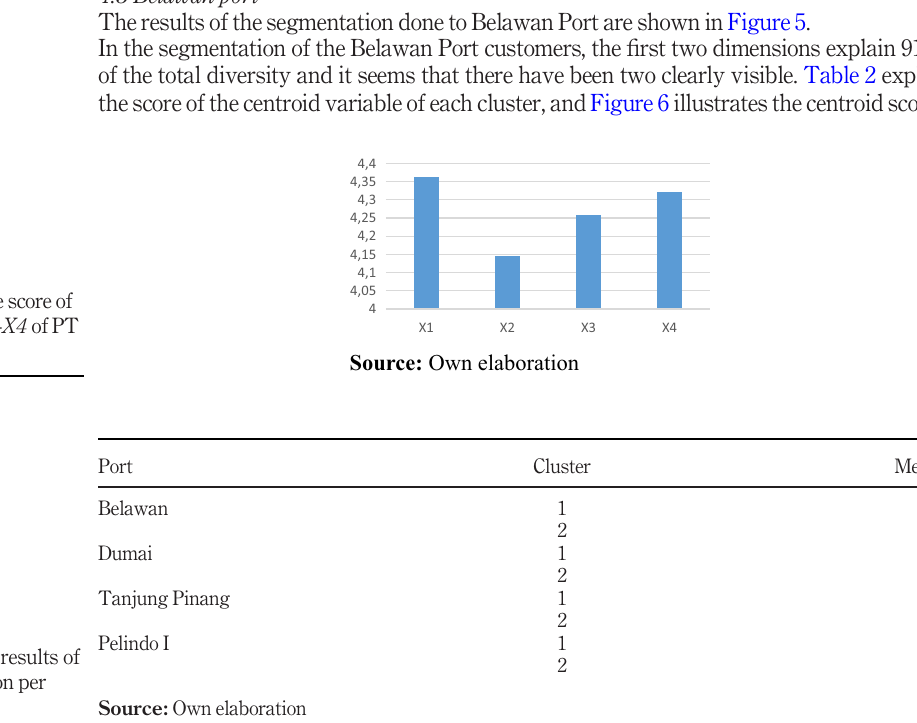
Table 1. Descriptive results of